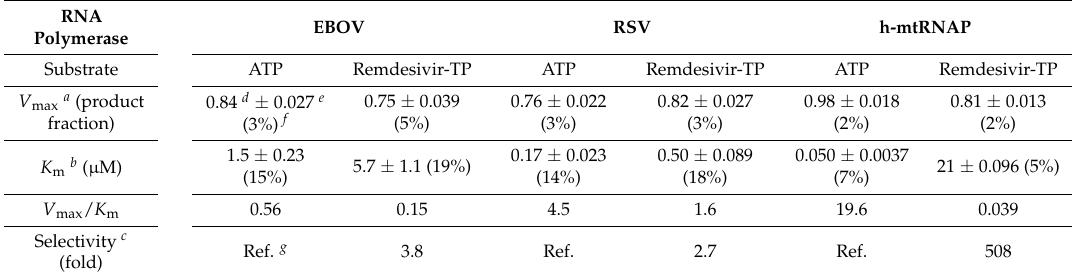
Table 1. RNA polymerase selectivity values for remdesivir-TP nucleotide